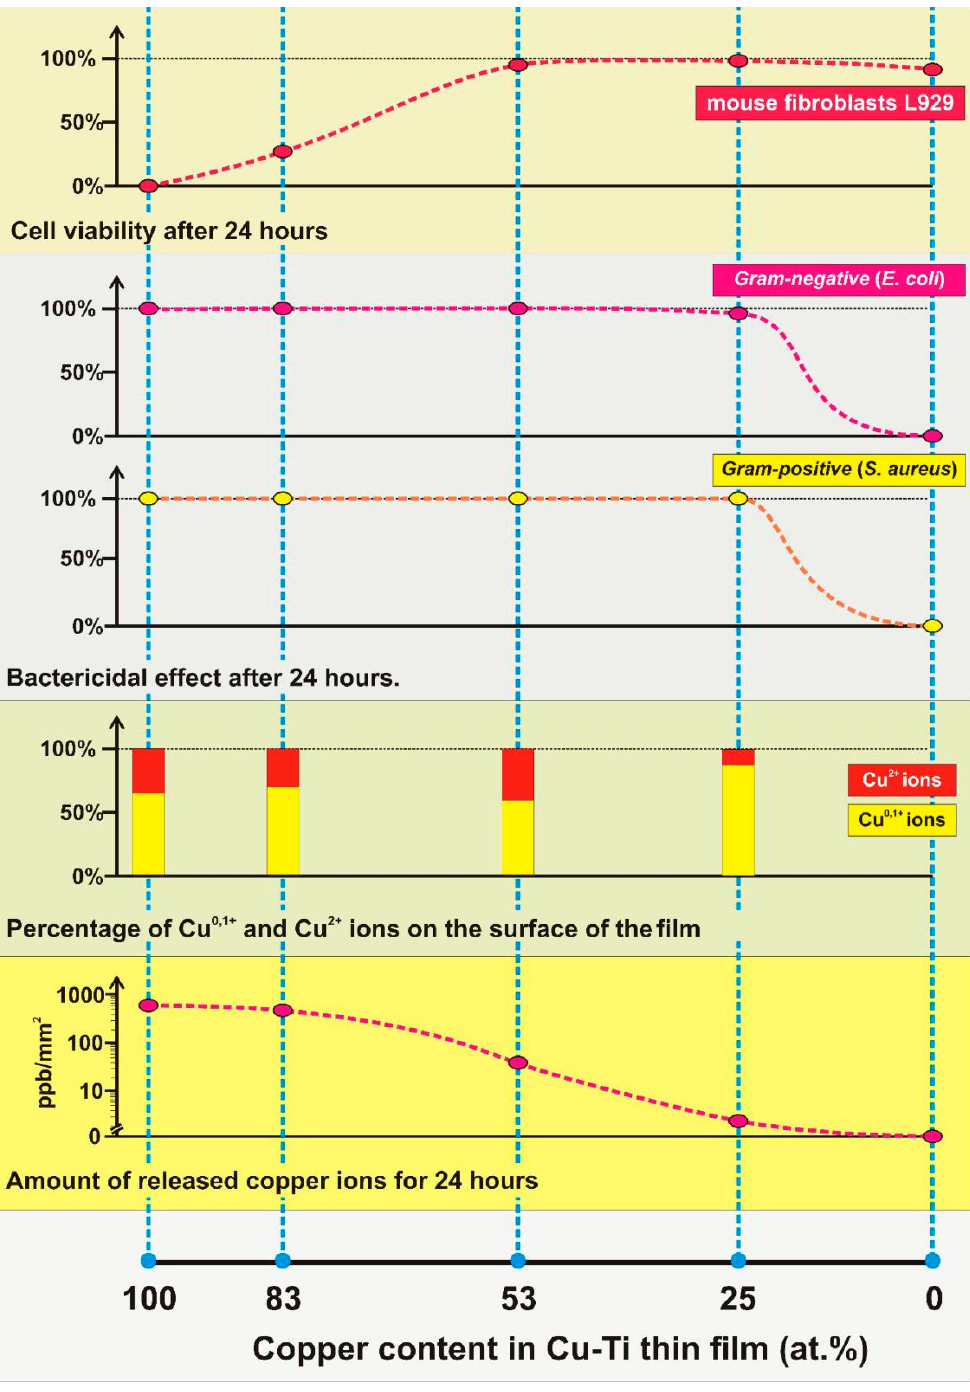
Figure 12. Quantitative results of the impact of material composition on biological properties (viability of L929 cells and bacteria E. coli and S. aureus ), oxidation state, and amount of copper ions released from the surface of nanocrystalline Cu-Ti thin films.